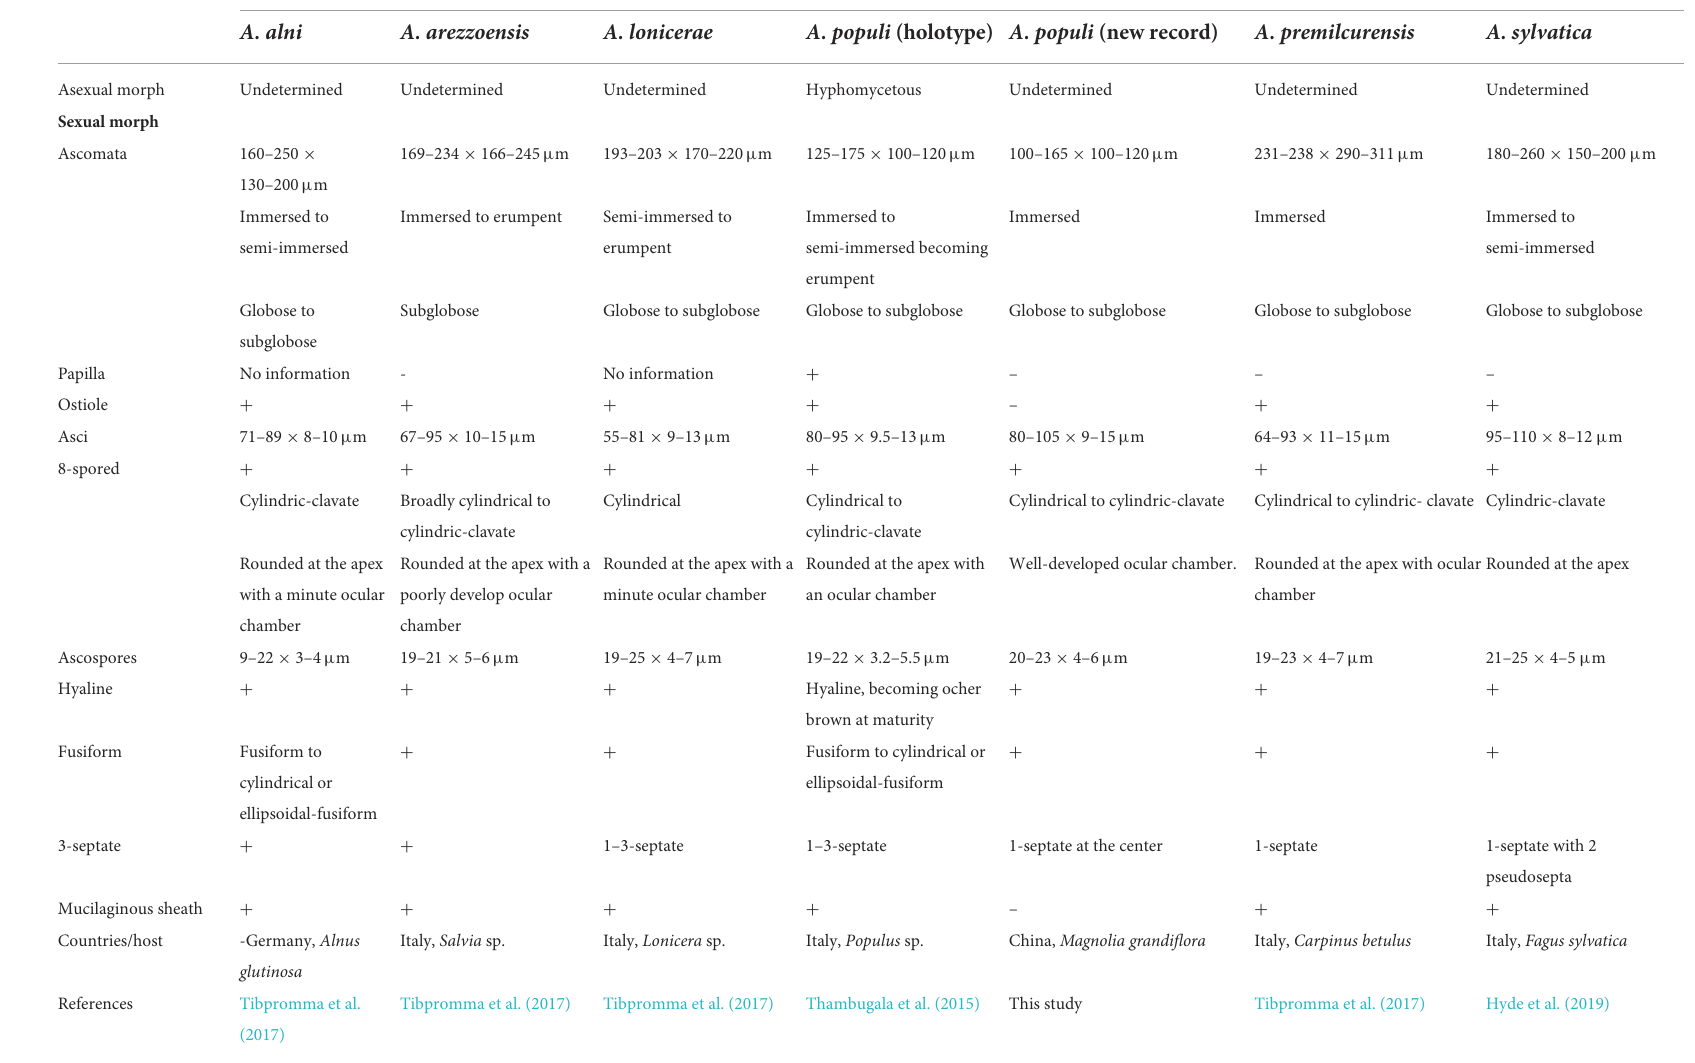
TABLE 3 Morphological comparisons, location, and hosts of Angustimassarina species phylogenetically related to the new